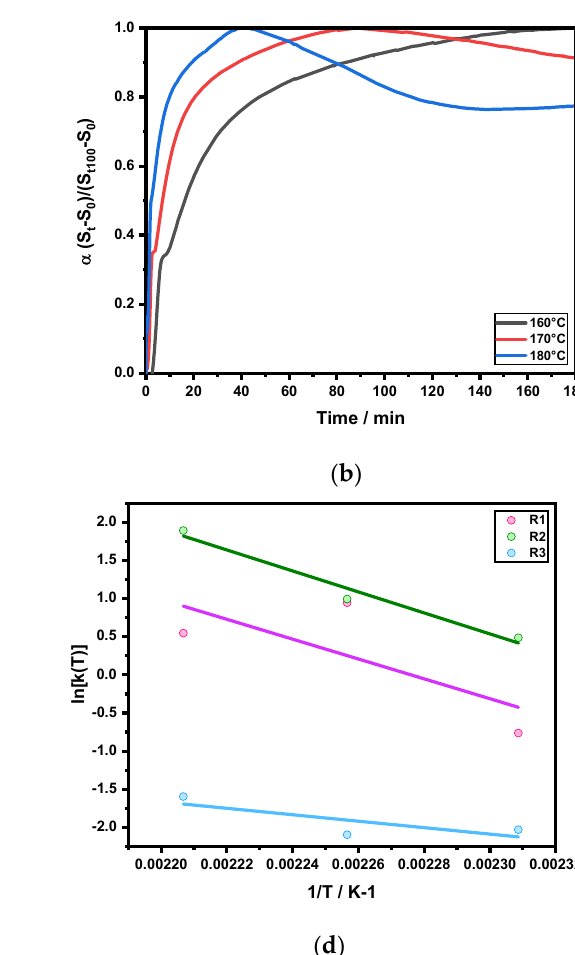
11 of 19 Table 4. Activation energy, E a , and pre-exponential factor k 0 values calculated from isothermal DSC analysis, for Reaction 1 (R1), Reaction 2 (R2) and Reaction 3 (R3). R1